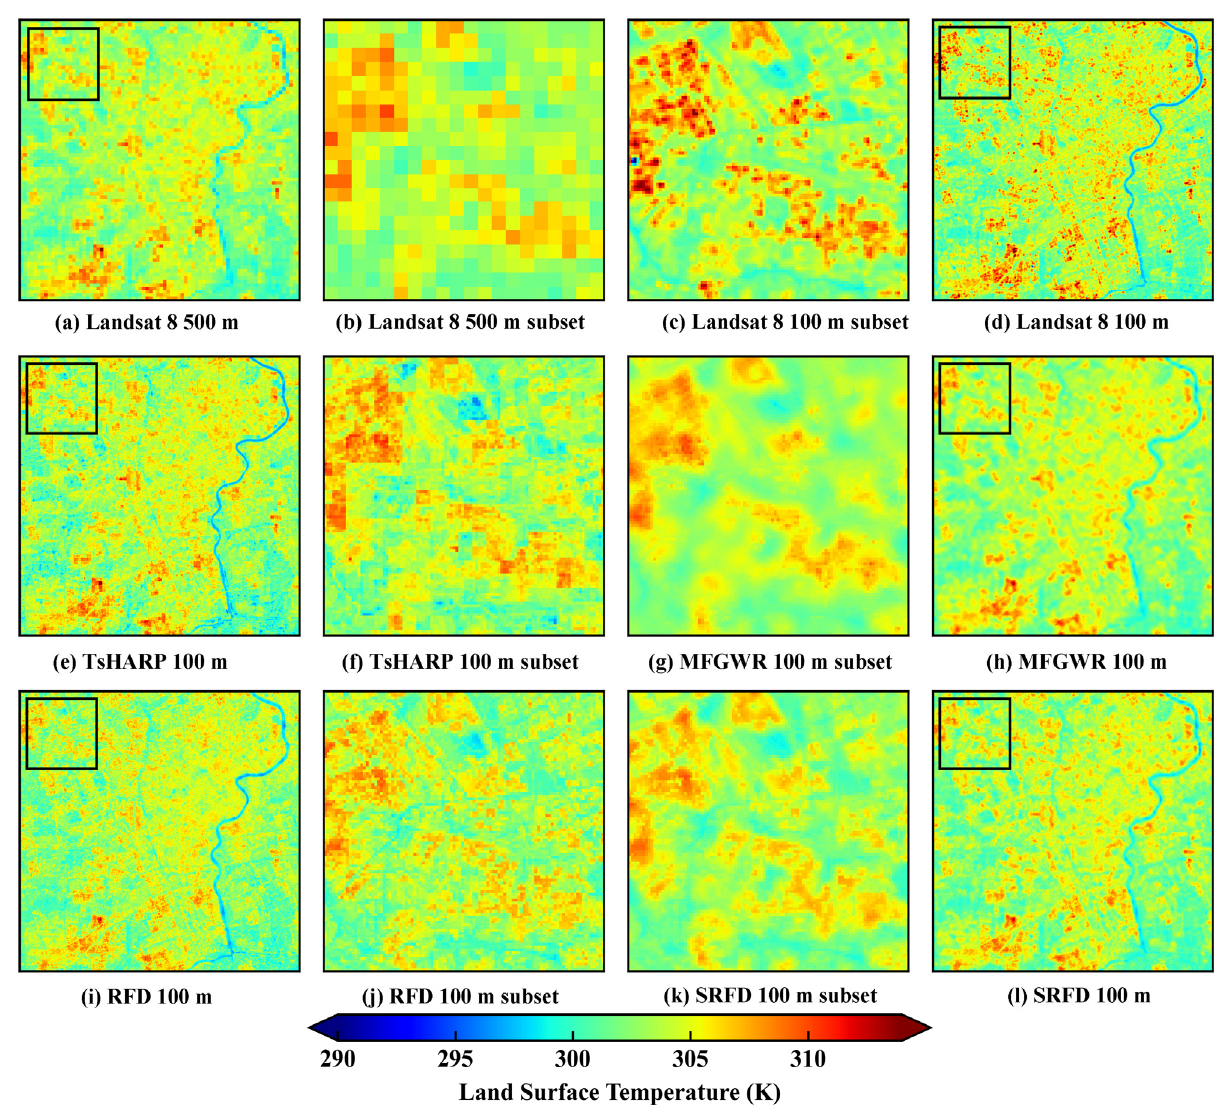
Figure 7. Visual comparison of different downscaling methods in image S1. ( a ) Landsat 8 LST (500-m). ( b ) Subset of Landsat 8 LST (500-m). ( c ) Subset of Landsat 8 LST (100-m). ( d ) Landsat 8 LST (100-m). ( e ) TsHARP downscaled LST (100-m). ( f ) Subset of TsHARP downscaled LST (100-m). ( g ) Subset of MFGWR downscaled LST (100-m). ( h ) MFGWR downscaled LST (100-m). ( i ) RFD downscaled LST (100-m). ( j ) Subset of RFD downscaled LST (100-m). ( k ) Subset of SRFD downscaled LST (100-m). ( l ) Subset of SRFD downscaled LST (100-m).